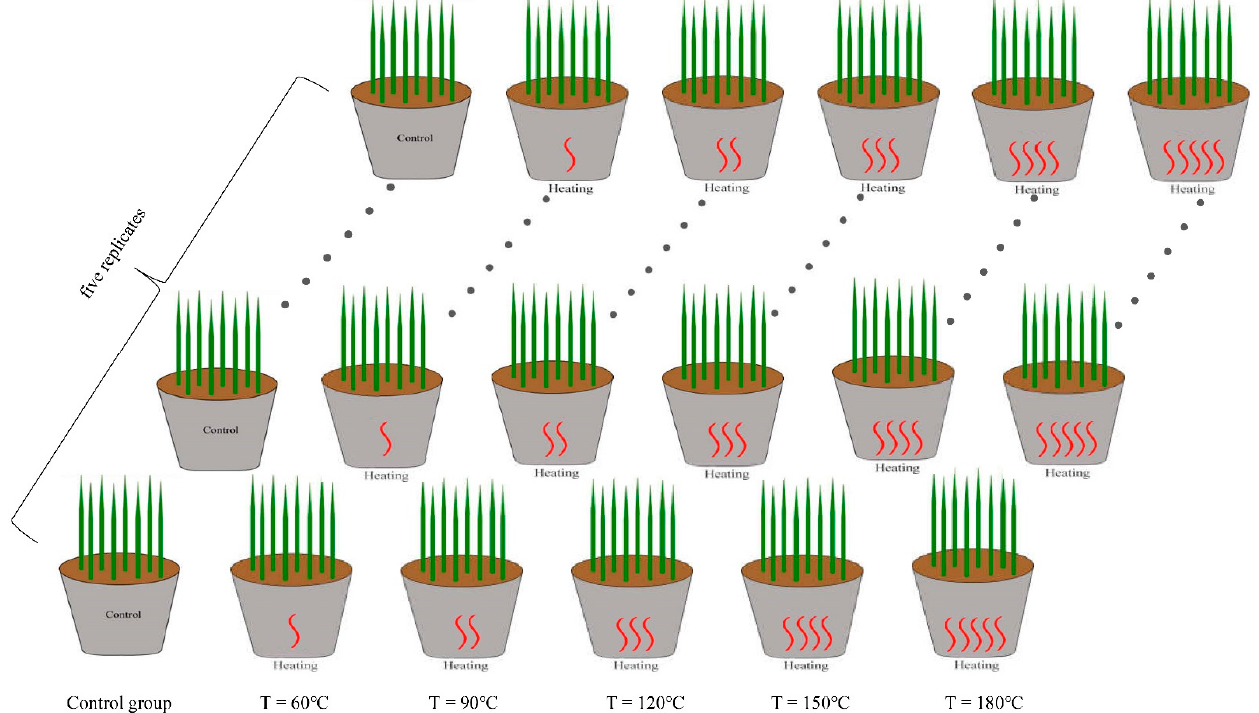
Figure 1. Potted simulation of alfalfa under heat stress.